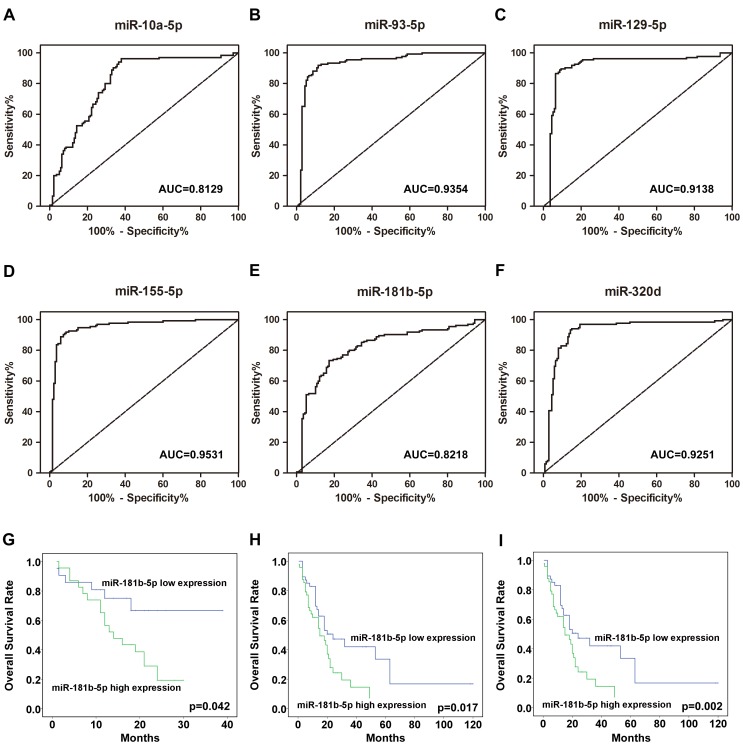
The ROC curves reflecting the ability of the serum levels of the 6 individual miRNAs (A-F), miR-10a-5p, miR-93-5p, miR-129-5p, miR-155-5p, miR-181b-5p, and miR-320d, to differentiate the AML cases (n = 140) from the controls (n = 135); Kaplan-Meier estimates of the overall survival of AML patients in the miR-181b-5p high-expression group compared with the miR-181b-5p low-expression group in the training set (G), in the validation set (H), and in both the training and validation sets (I).